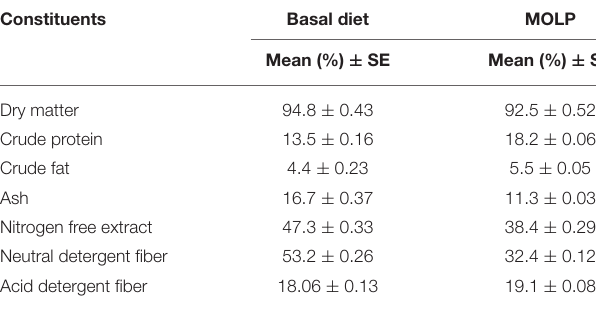
TABLE 2 | Chemical composition of basal diet and MOLP (DM basis). Constituents